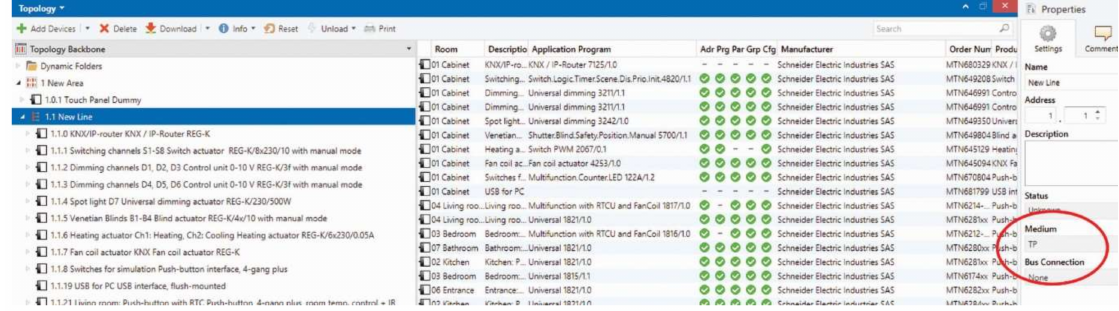
Figure 2. Created KNX topology and selected medium TP KNX in the software (SW) tool ETS 5.